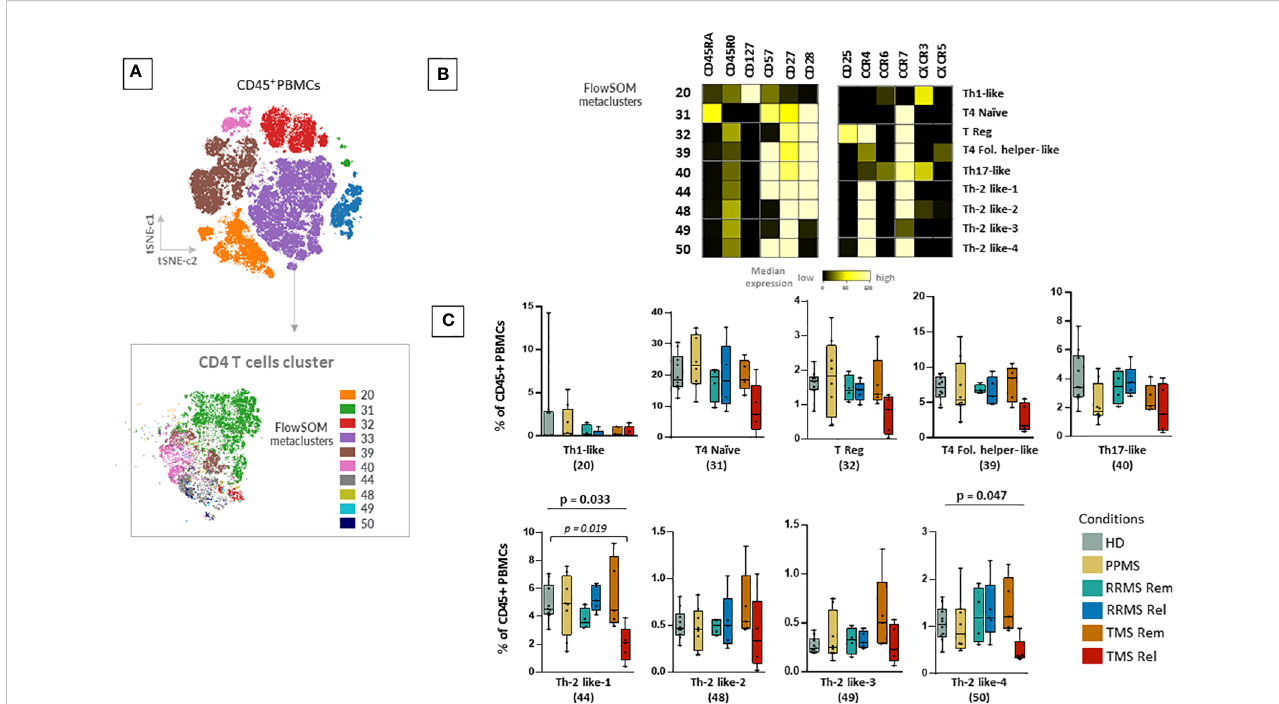
FIGURE 4 Selective CD4+ T cell lymphopenia in TMS patients during relapse. (A) FlowSOM resulted metaclusters in CD4+ T helper cells projected on the tSNE map (a representative example from one healthy donor is shown here). (B) Heatmap for key markers to identify to characterize metaclusters. A tentative biological name was assigned to each metacluster based on the most abundant myeloid markers expressed by each cluster. (C) MS patients strati fi ed in different disease subgroups (PPMS; n=8, RRMS; n=9, TMS; n=10). RRMS and TMS were further subdivided in those in remission (RRMS; n=4, TMS; n=5) and relapse (RRMS; n=4, TMS; n=5). Box plots showing the frequency (expressed as % of CD45+ cells) of each CD4+ T cell metacluster in peripheral blood mononuclear cells of patient subgroups and healthy donors (n=10). Each dot represents the value of each sample. Statistically signi fi cant changes are shown in the image (p < 0.05 was considered signi fi cant, non-parametric Kruskal Wallis test with correction for multiple comparisons (FDR) was applied, p<0.05, p<0.01). PPMS, Primary Progressive Multiple Sclerosis; RRMS, Relapsing-Remitting Multiple Sclerosis; Rem, Remission; Rel, Relapse; TMS, Tumefactive Multiple Sclerosis; HD, Healthy donors; IQR, interquartile range; t-SNE, t-distributed stochastic neighbor embedding; FlowSOM, Flow Self- Organizing Map; Eff., Effector cell population; T4; CD4+ T cell, Fol., Follicular T helper cells, Th1-like, T helper 1-like cells, Th-2 like; T helper 2 -like cells; CCR, CC chemokine receptors; CXCR, CXC chemokine receptor; FDR, false discovery